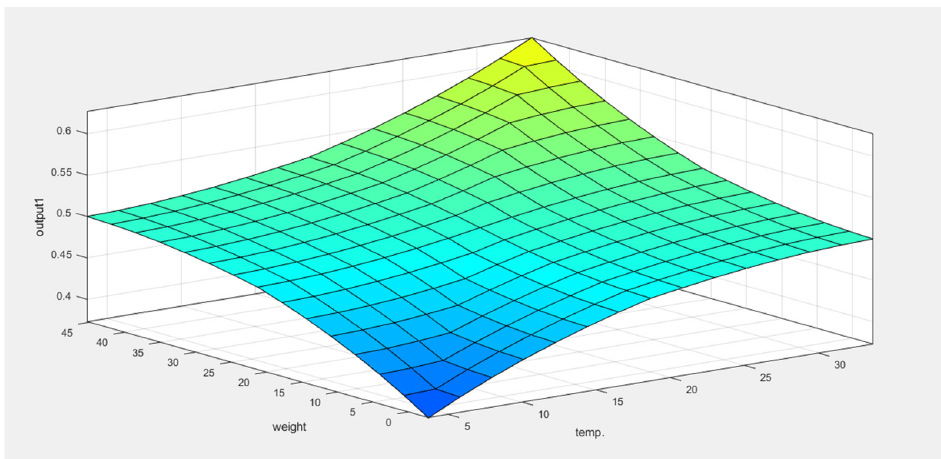
Figure 10. Response Surface for the weight and temp. parameters in the fuzzy system.